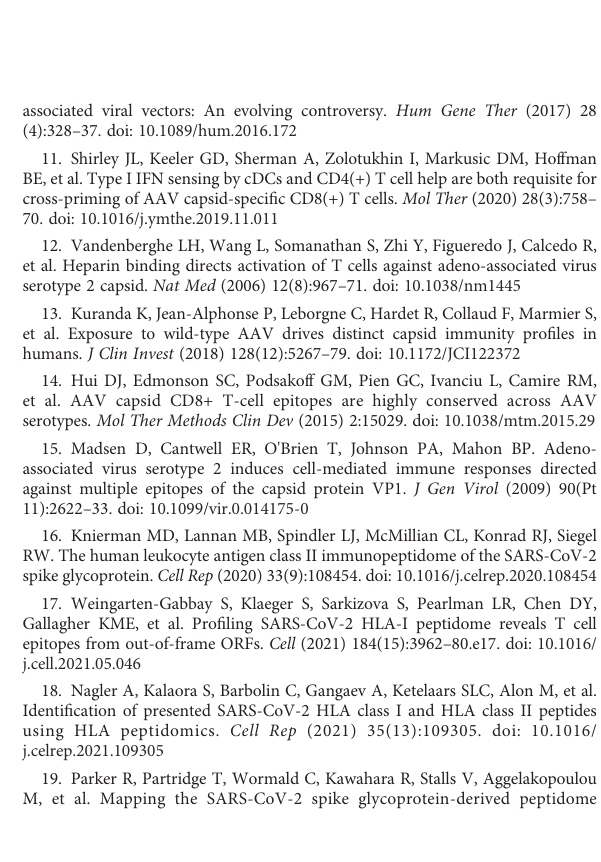
SUPPLEMENTARY TABLE 3 Conserved peptides. Related to Figure